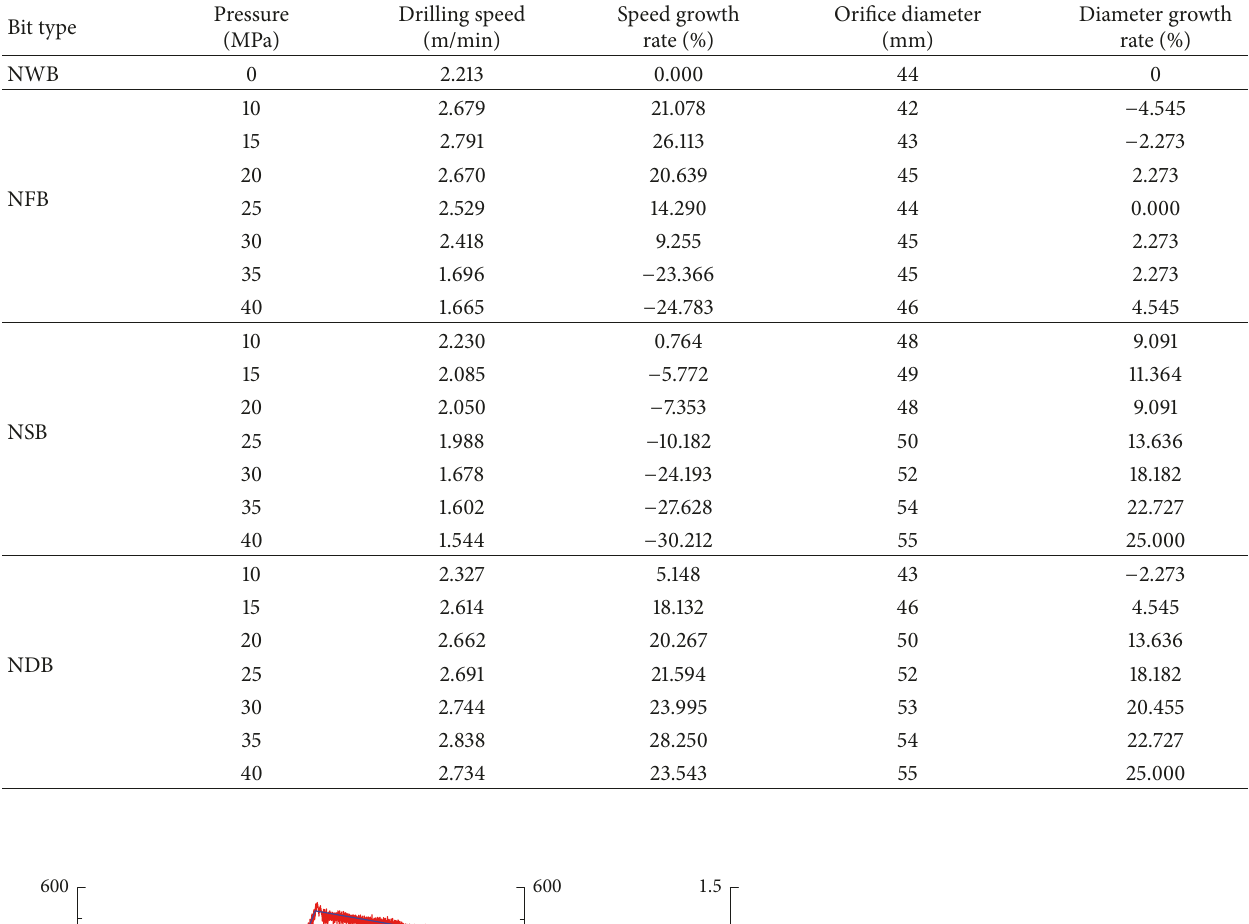
Table 3: Drilling speed assisted with water jet under different configuration modes.